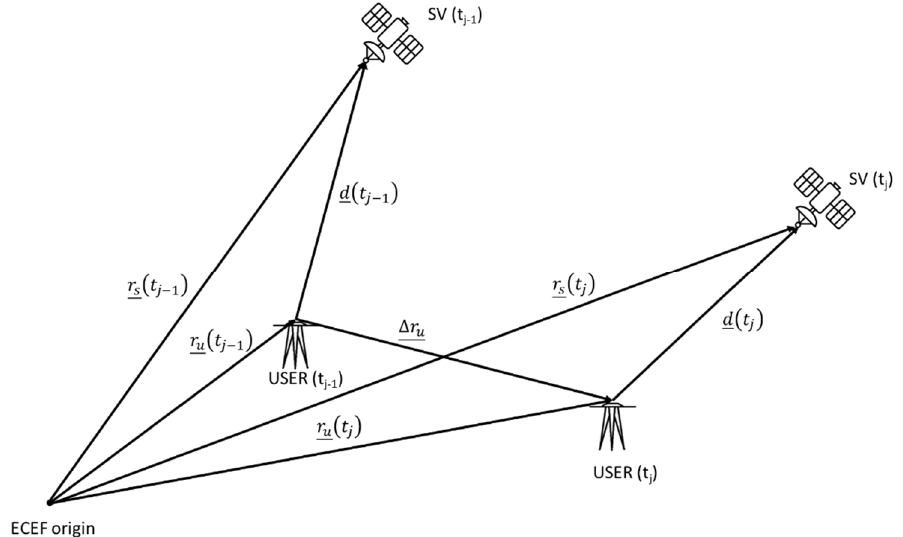
Figure 2. Satellite–Receiver relative geometry (modified from [9]).